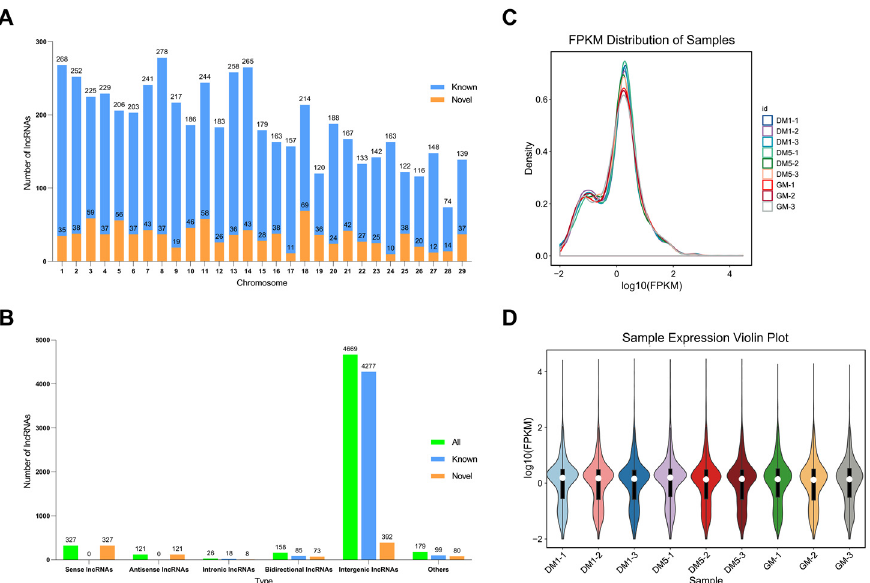
Figure 2. Identification and characterization of lncRNA in goat MuSCs. ( A ) Type statistics of identified lncRNAs. ( B ) Chromosome distribution of identified lncRNAs. ( C ) The density distribution of lncRNAs was according to log10(FPKM). ( D ) The nine sample expressions in a violin plot, which was replaced by log10(FPKM).